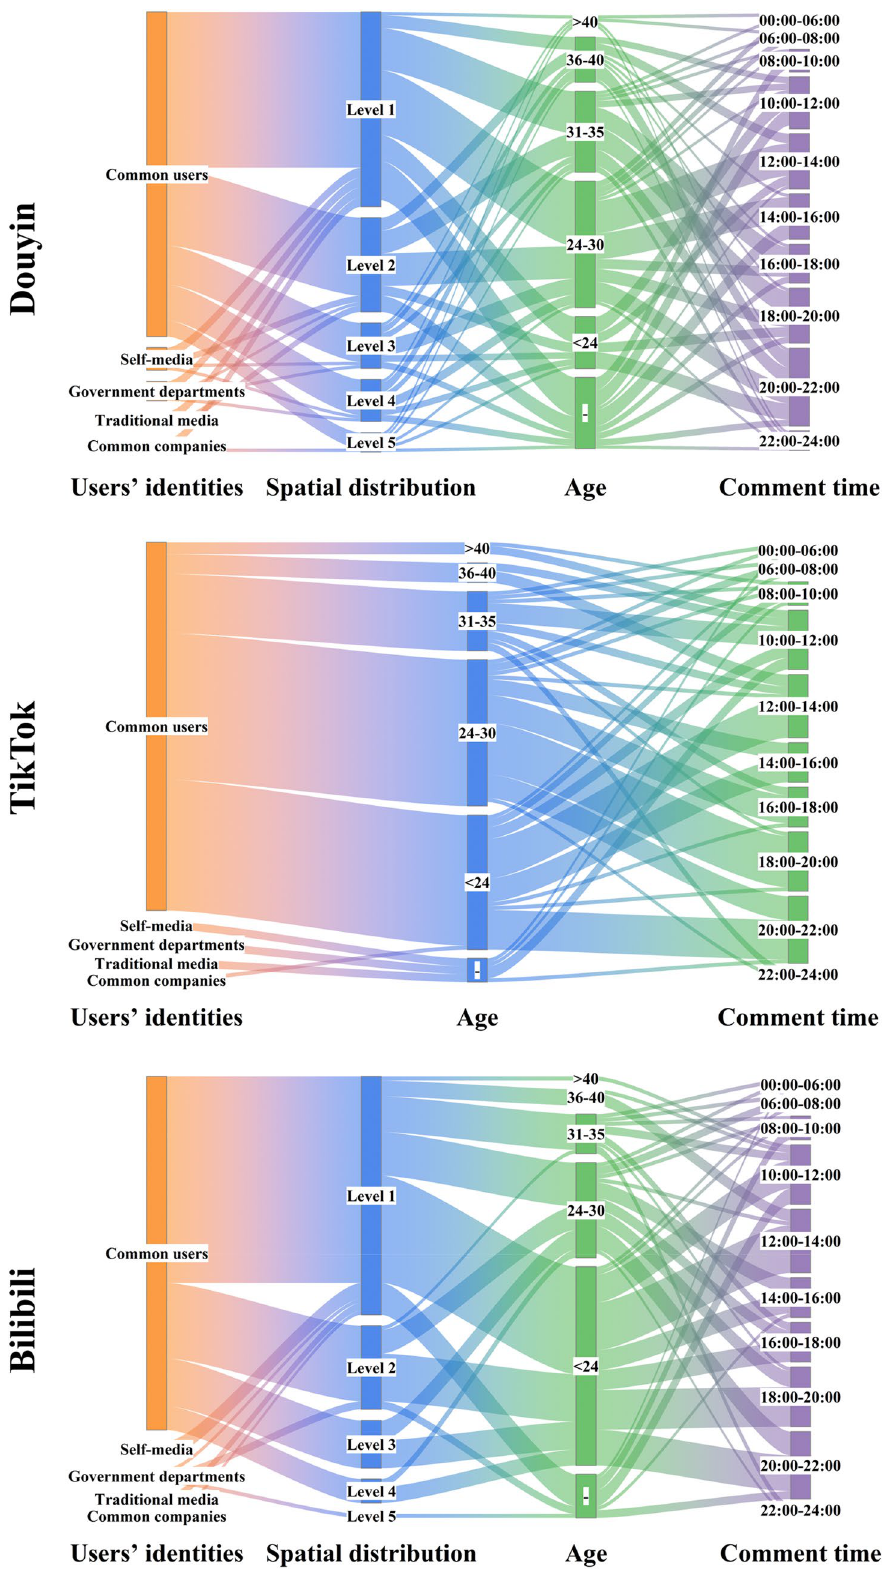
Figure 8. Sankey diagram representation of EC members’ identities, spatial distribution, age and comment time. The width of the lane is proportional to the degree to which it is weighted out and the inner colored connecting bands indicate the flow and direction of the data